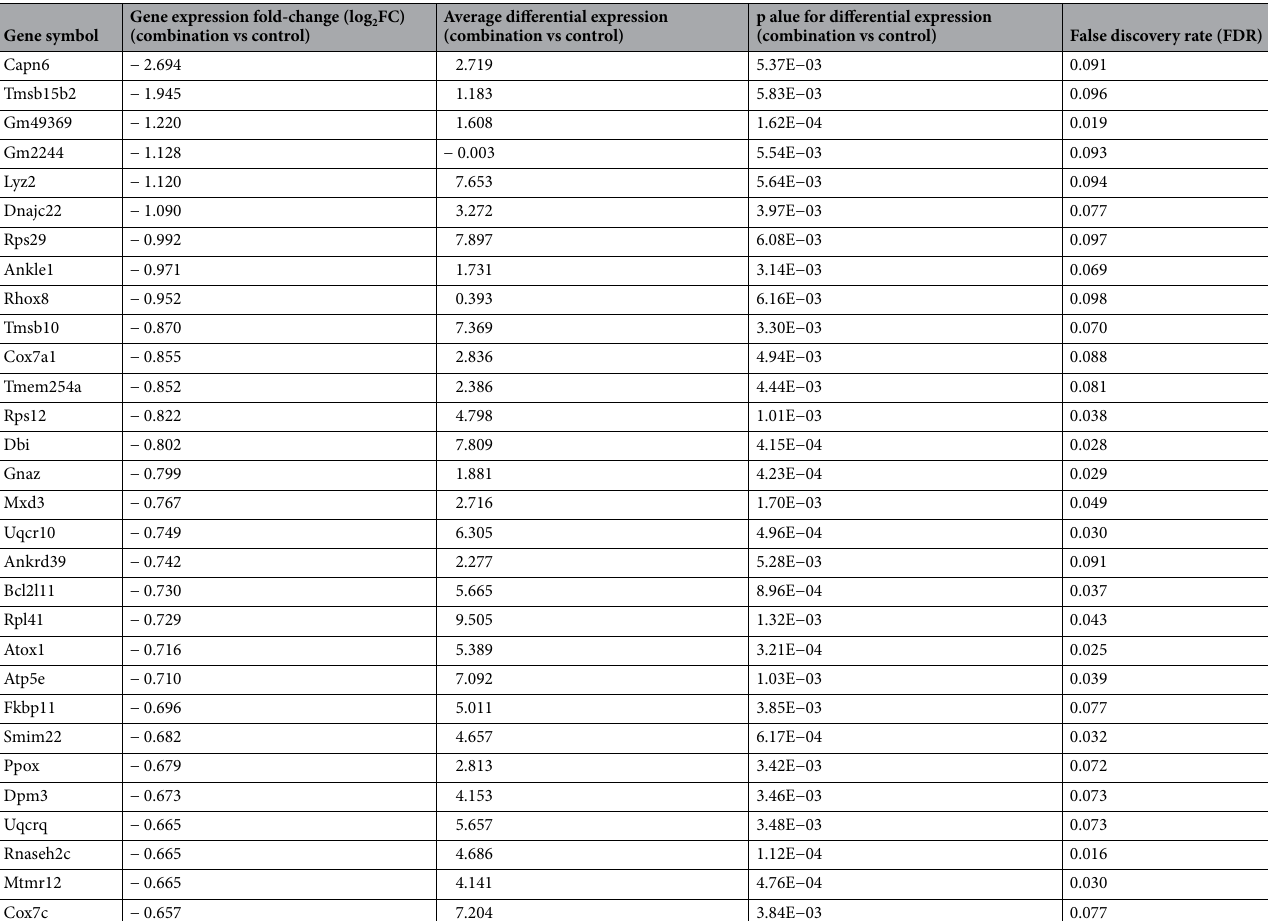
Table 1. Top 30 differentially expressed down-regulated genes in the combination (BSp 851 + GTPs) treatment